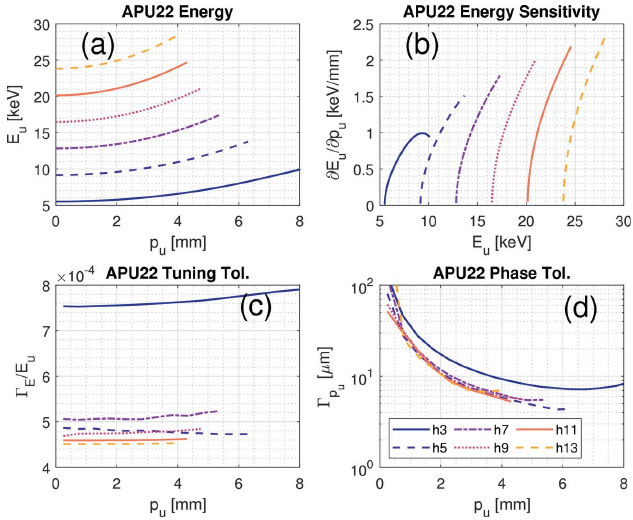
Figure 5 APU22 characteristics for the different harmonics in the energy range between 5.7 and 28 keV at the EMA and the MANACA´ beamlines at Sirius: ( a ) peak emission energy E u as a function of the phase p u ; ( b ) variation correlation between E u and p u as a function of E u ; ( c ) energy tuning tolerance ratio as a function of p u ; and ( d ) phase error tolerance (cid:3) as a function of p u p u